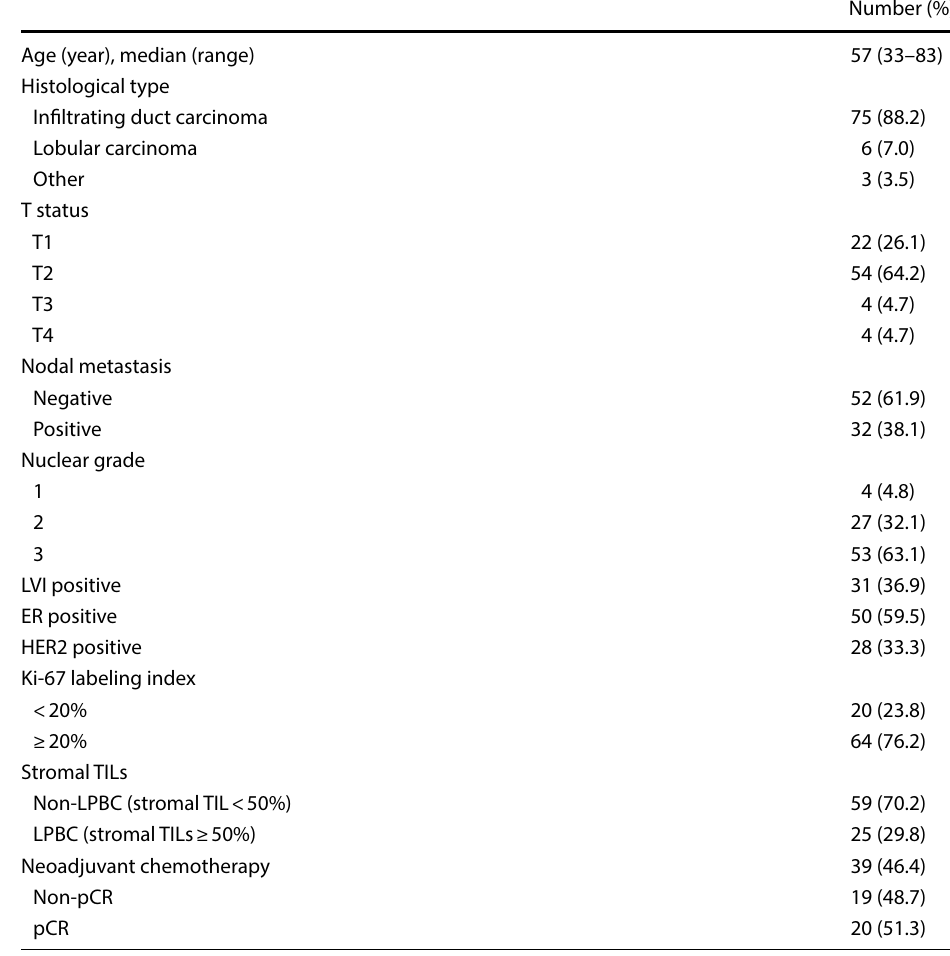
Table 1 Patient